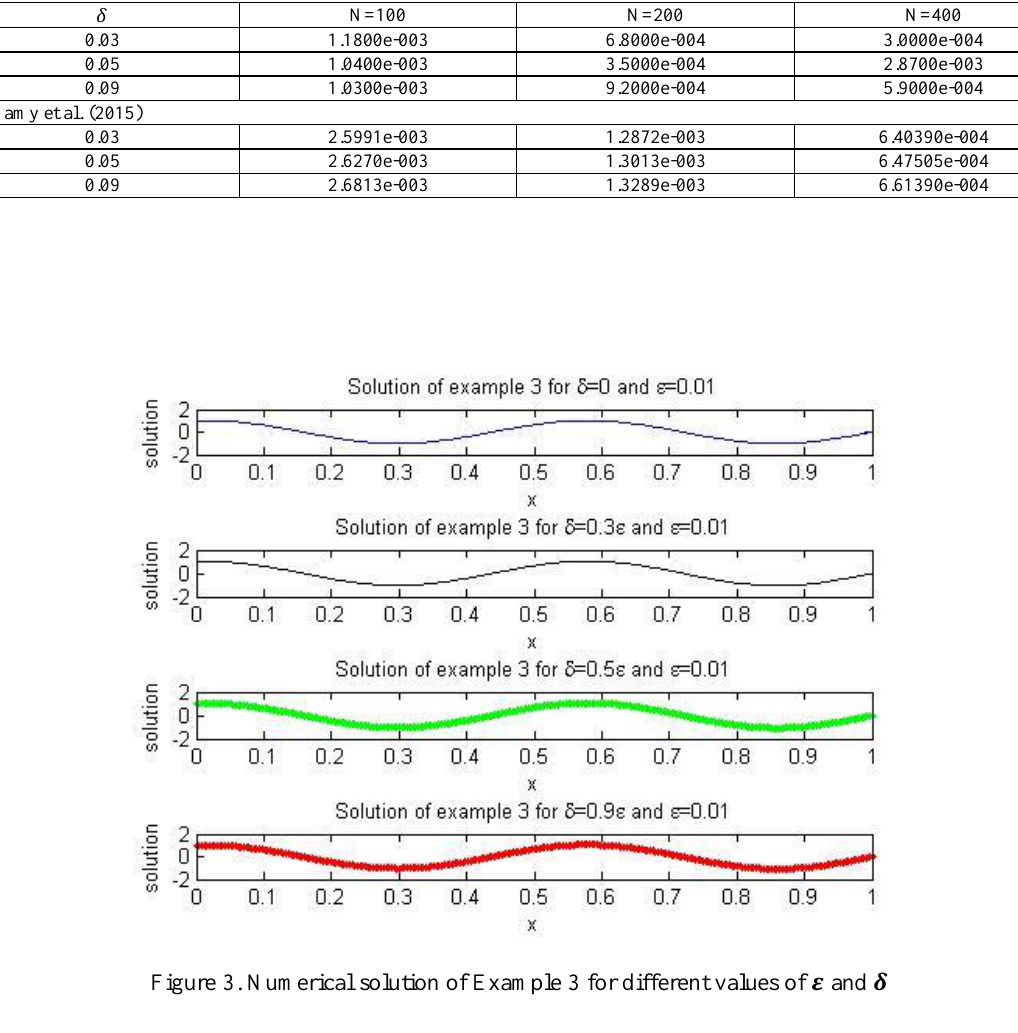
Table 5. Maximum absolute error obtained for Example 3 for 𝛆 = 𝟎. 𝟏